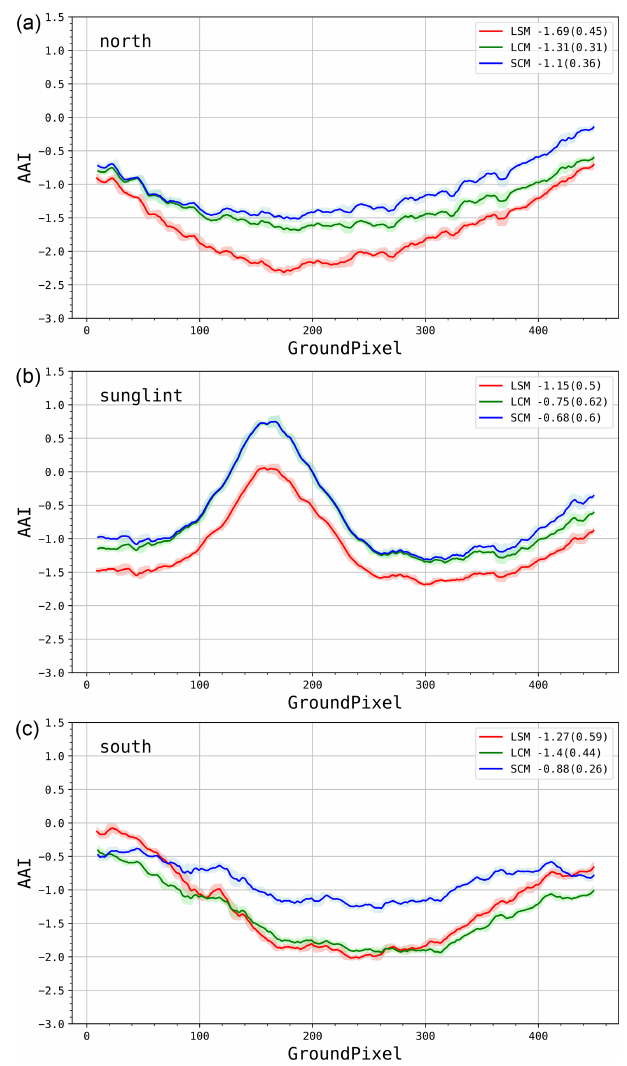
Figure 12. TROPOMI AAI as a function of ground pixels for the north (a) , sunglint (b) , and south (c) east–west cross sections. The three different models are shown: LSM (red), LCM (green), and SCM (blue). The numbers in the legend show the 10-pixel rolling mean and standard deviation (between